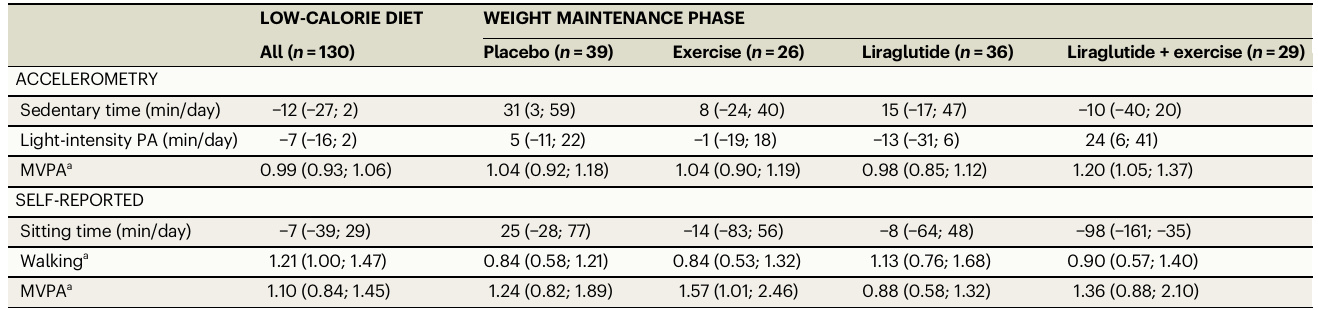
Table 3 | Changes in sedentary time and physical activity during low-calorie diet and weight loss maintenance by intervention